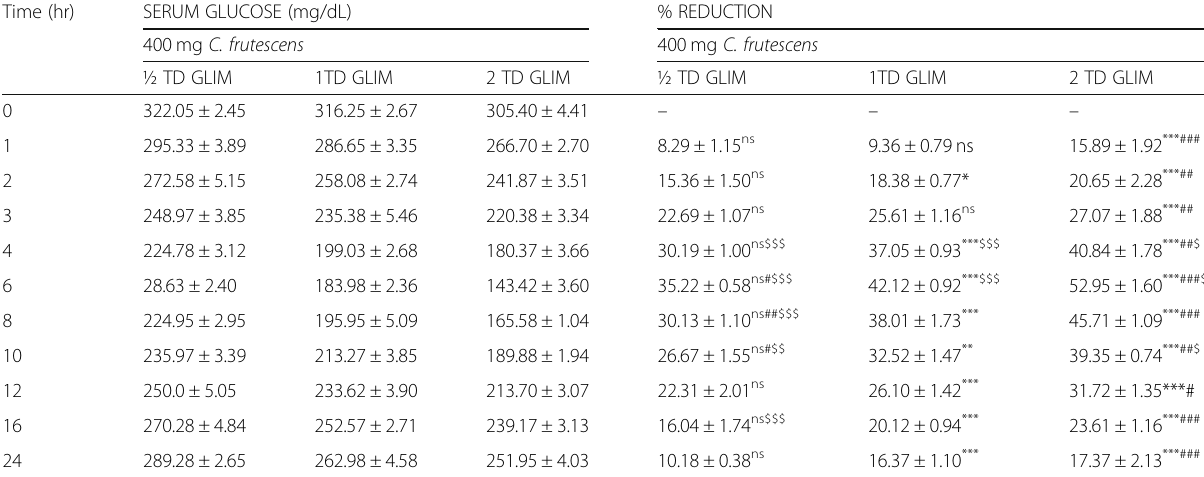
(Table No. 41, 42, 43). Repeated dose of AQEFCF 100, 200, 400 mg/Kg, p.o. treatment followed by glimepiride 2TD (0. 144 mg/200 g, p.o) in respective groups has Table 3 Influence of single dose treatment of C. frutescens (400 mg/kg) on antidiabetic activity of glimepiride in diabetic rats Time (hr) SERUM GLUCOSE (mg/dL) %